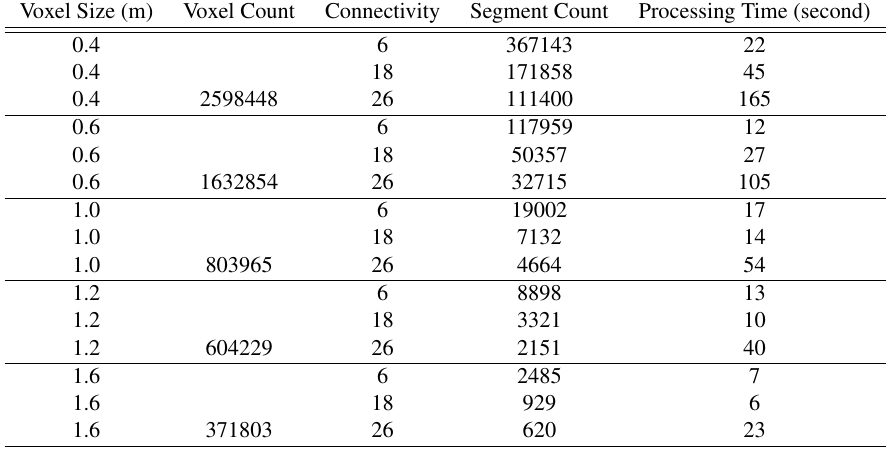
Table 1. Impact of voxel size and voxel connectivity on the point cloud dataset for the modelling of heathland